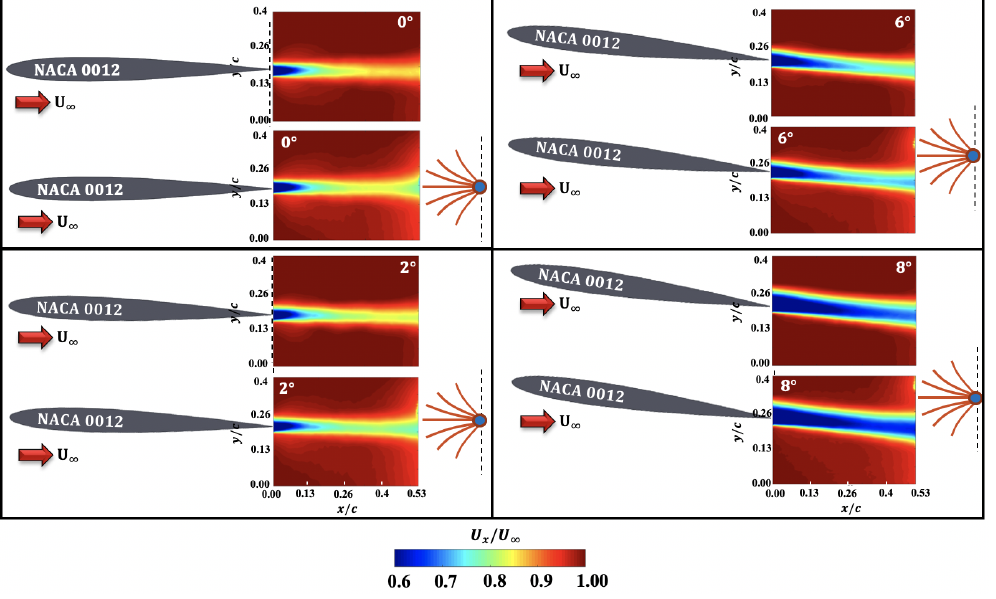
Figure 17. Momentum deficit contours in the wake of NACA 0012 airfoil with and without the inverted PVDF.